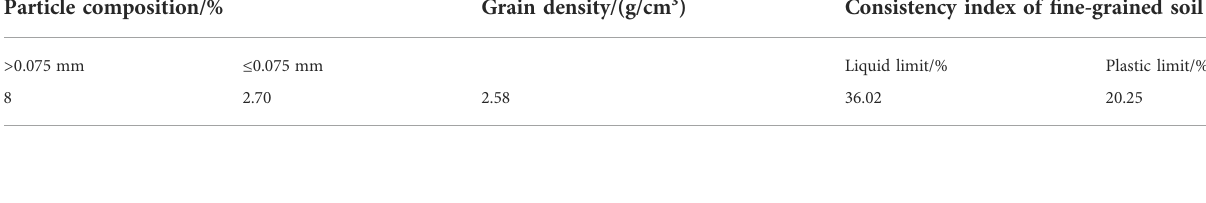
TABLE 1 Basic physical properties of the soil sample.